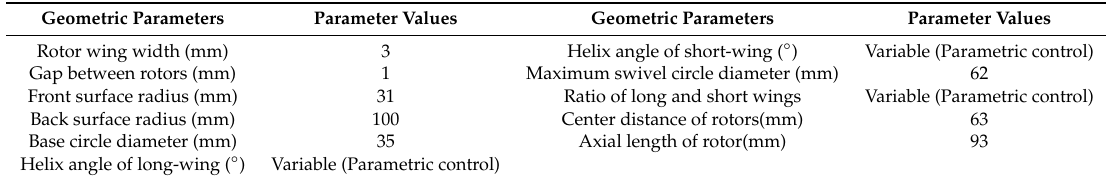
Table 1. Rotor design